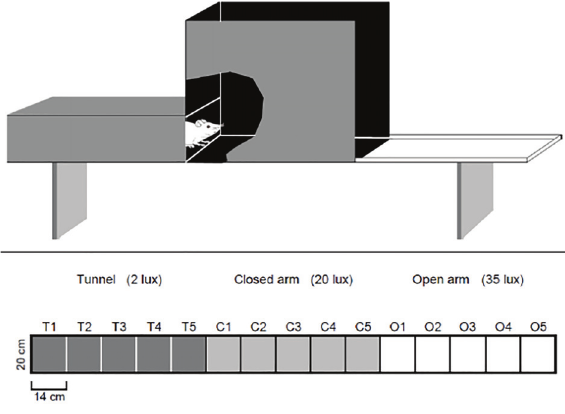
Figure 1. Schematic representation (upper part) and a top view of the EGA (lower part). Dark gray indicates the tunnel compartment with area division (T1 to T5); light gray indicates the closed arm compartment (C1 to C5); and white indicates the open arm compartment (O1 to